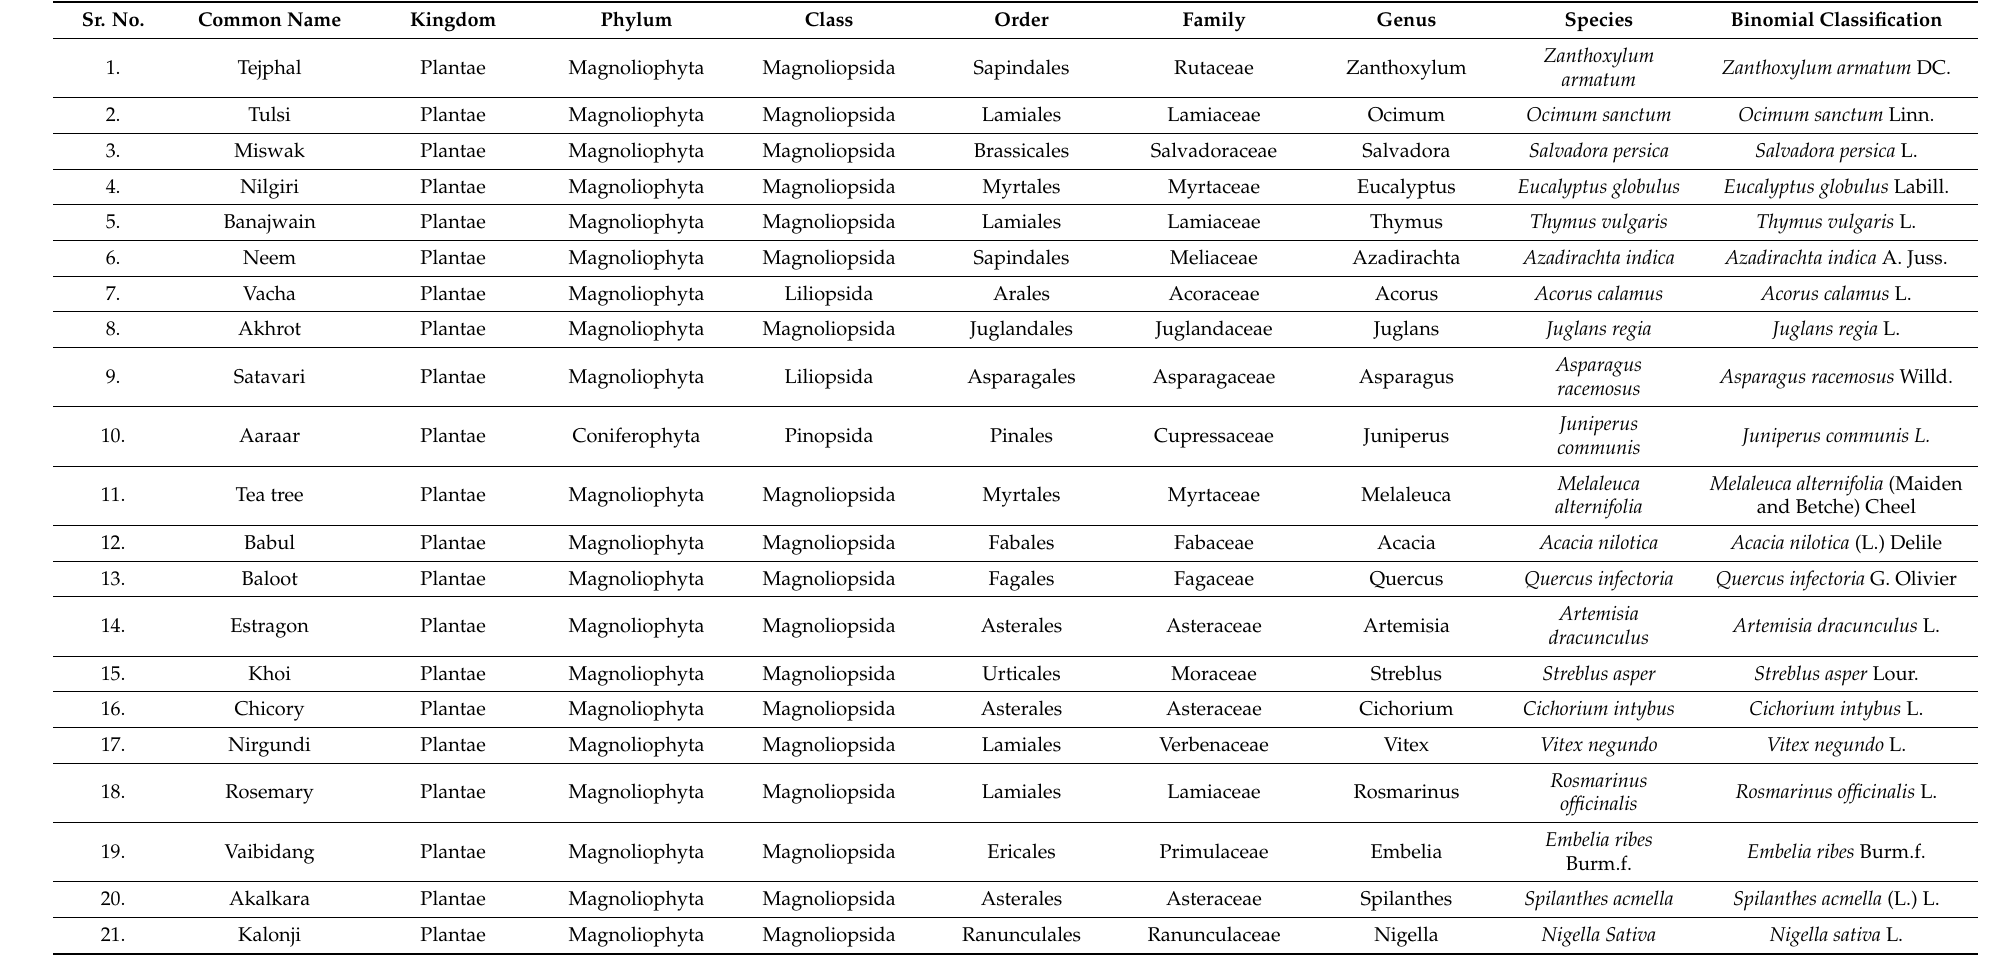
Table 1. Systematic classification of the medicinal plants discussed in the current